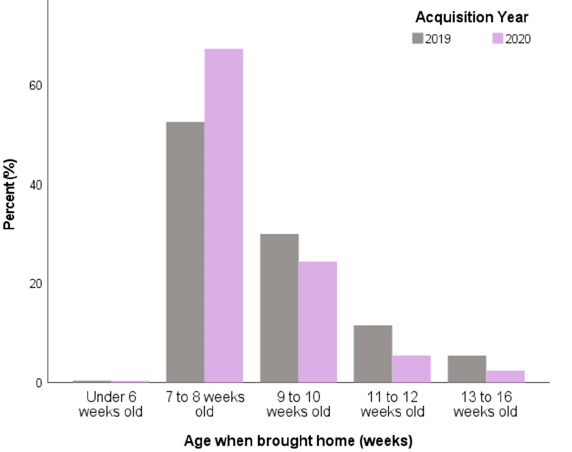
Figure 6. Age of puppies at acquisition ( n = 5548) with comparison between 2019 owners ( n = 1150) Figure 6. Interval from deciding to look for a puppy to acquisition (bringing puppy home) ( n = 5401) with comparison between 2019 owners ( n = 1124) and Pandemic Puppy owners ( n = 4277) in the UK. and Pandemic Puppy owners ( n = 4398) in the